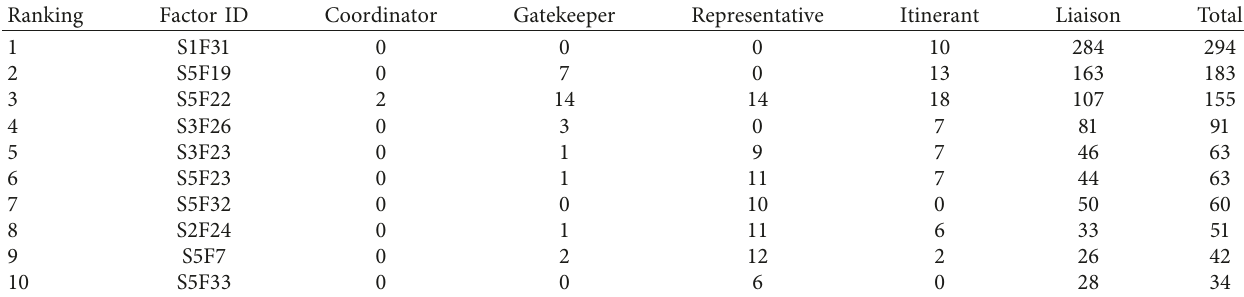
Table 3: Critical factors for BIM adoption in SMEs based on brokerage analysis.